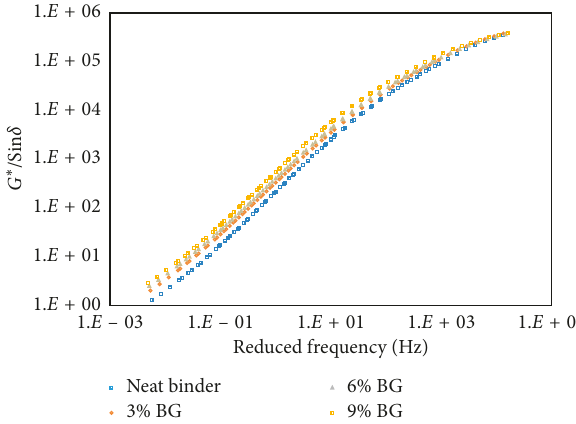
Figure 9: Master curve for G ∗ /sin δ at 58 ° C.